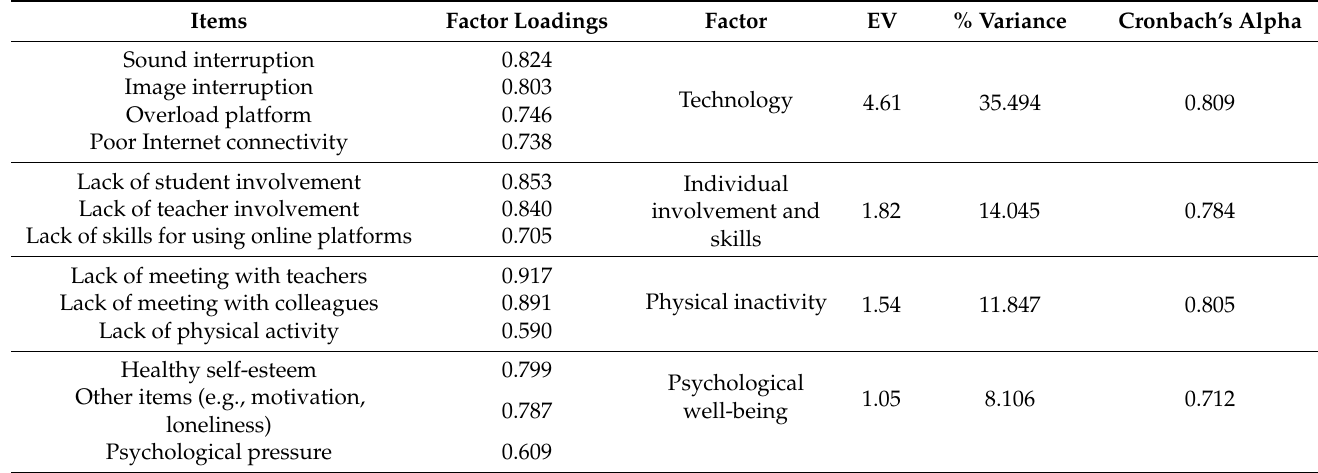
Table 4. Testing data from the students’ group.